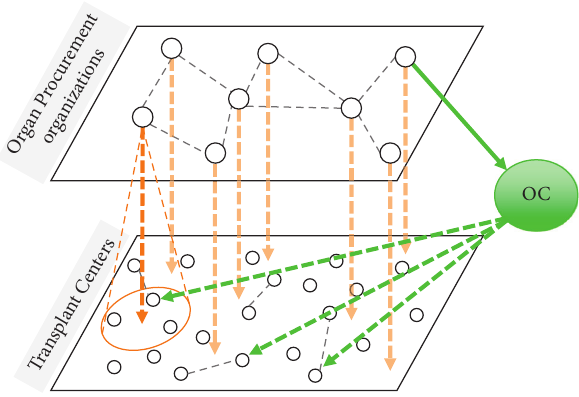
Figure 2: Directed multiplex structure of information sharing within the OPTN during allocation. Each OPO (top layer) has authority in a geographical region that encapsulates several transplant hospitals (bottom layer). The two spatial dimensions of the layers correspond to geographical relationships, since physical distance influences organizational ties and authority. An ellipse covering multiple hospitals illustrates OPOs’ one-to-many rela- tionship with transplant hospitals. Physically adjacent OPOs typically have emergent links arising from the geographic locality preference of policy. Transplant hospitals may develop links through personnel exchanges from recruitment, attrition, and residents who become physicians at the other transplant hospitals. The Organ Center (OC) facilitates bridging between disparate organizations during allocation. Note that the number of nodes illustrated in each layer is smaller than the actual system and is only to convey that transplant hospitals outnumber